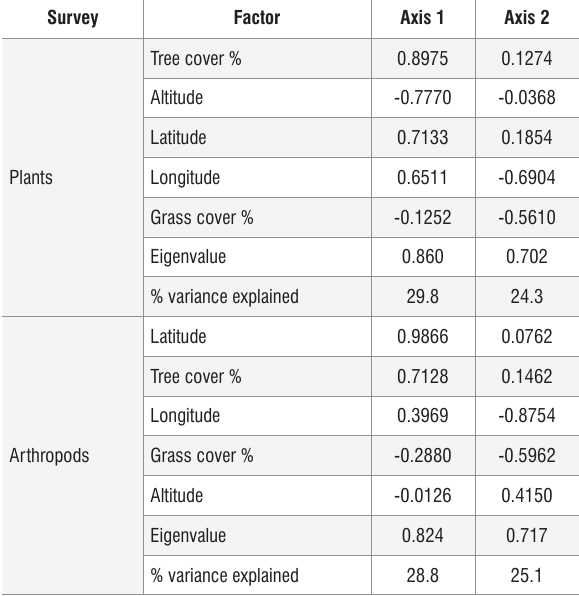
Table 5: Correlations of ordination axes with selected environmental factors, eigenvalues and percentage variance explained for canonical correspondence analysis